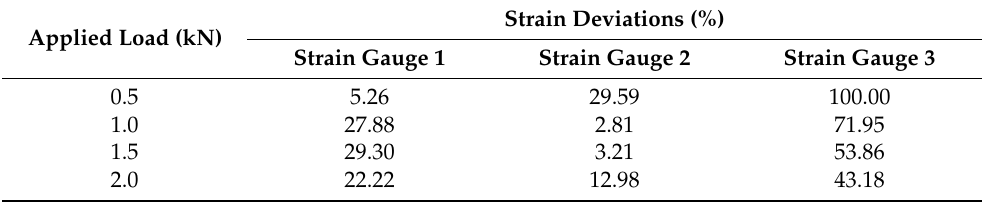
Table 6. Strain deviations between experimental and finite element method (FEM)